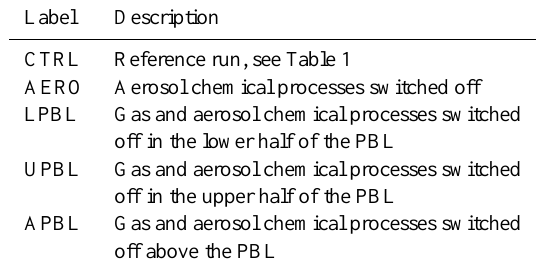
Table 2. Description of sensitivity tests with WRF/Chem model.